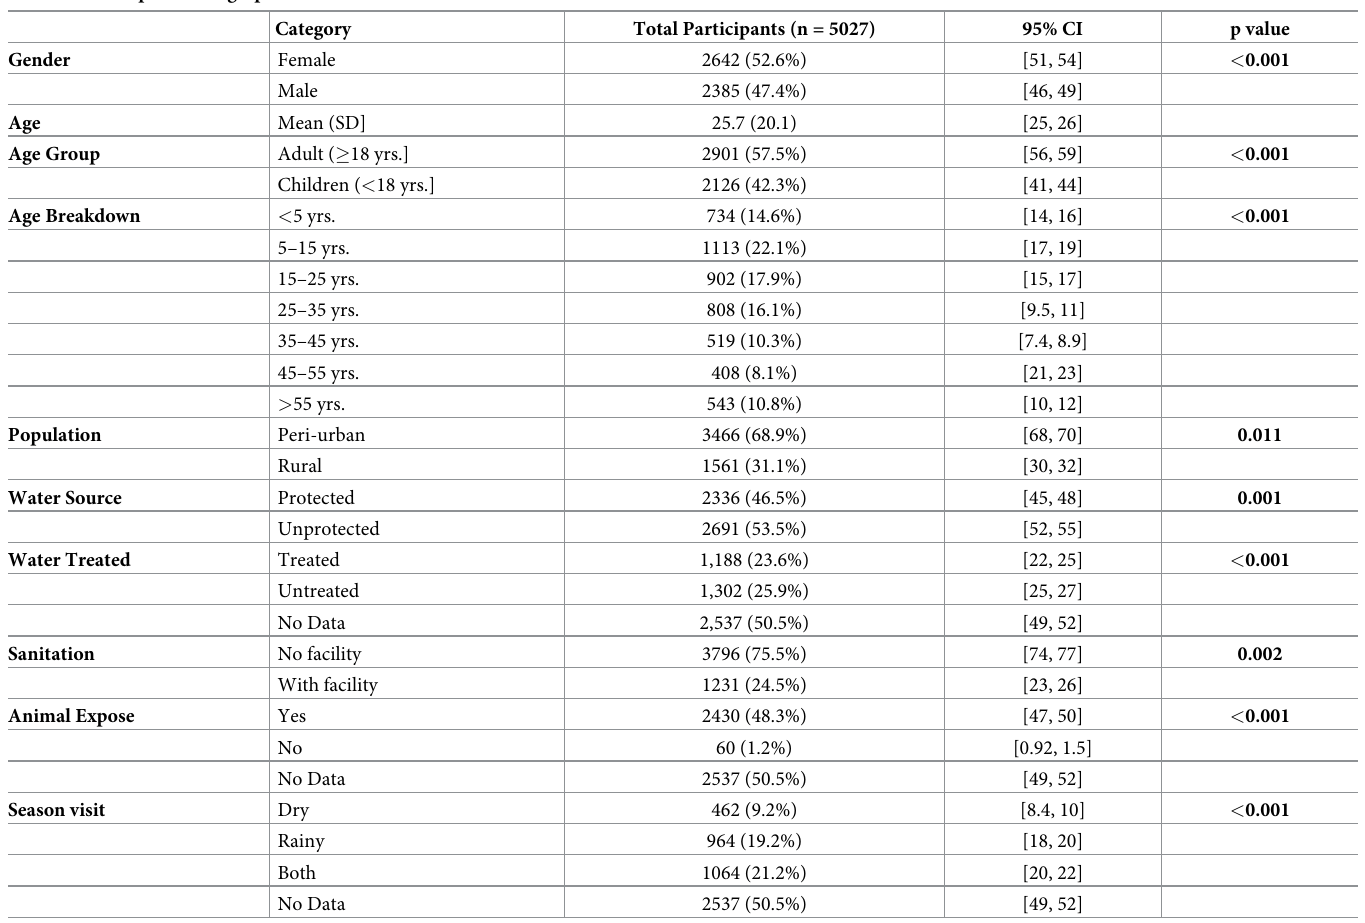
Table 1. Participant